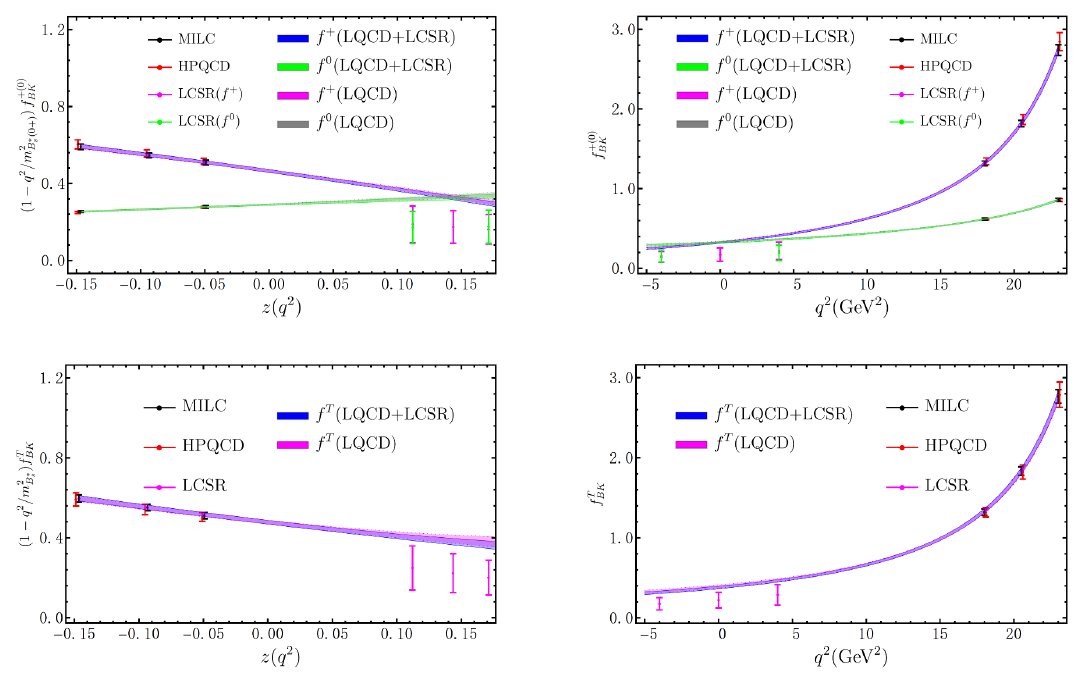
Figure 10 . Theory predictions for the complete set of the semileptonic B → K form factors versus z (left panel) and versus q 2 (right panel) in the entire kinematic region obtained by carrying out the combined BCL z -fit of the updated LCSR (from this work) and lattice simulation (from [14, 15]) data points. We further display the yielding numerical results of these essential form factors by performing an independent z -series fit against the “ only lattice QCD ” data points [14, 15] exclusively for an instructive